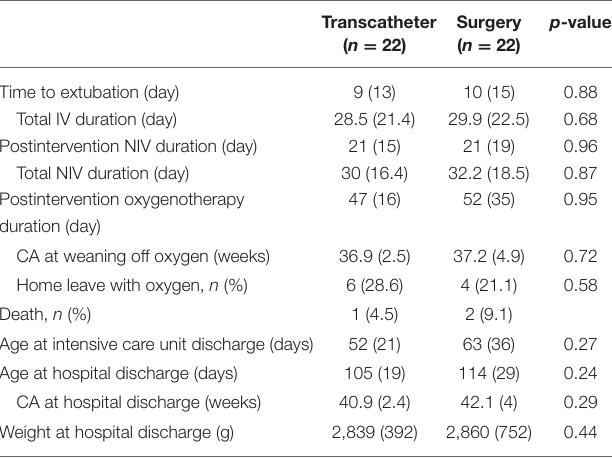
TABLE 2 | Perioperative outcomes.